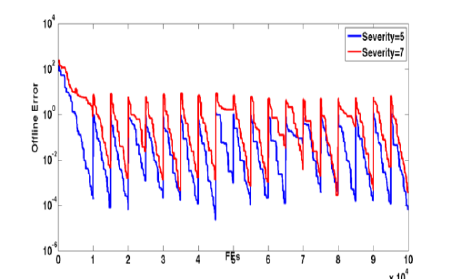
Figure 12. Offline error for proposed algorithm with shift Figure 13. Cover of peaks with iteration = 500000, lengths of 5 and 7 with frequency of 5000, and peaks number of frequency change = 10000, peak number = 10, population 10. size = 300, shift length = 1, and other default parameter values for MPB benchmark.